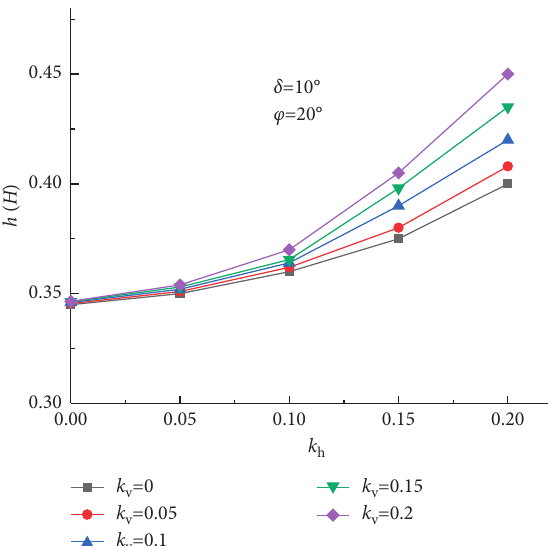
Figure 14: The variation curve of the height of the resultant force acting point with ( k ) h and ( k ) v